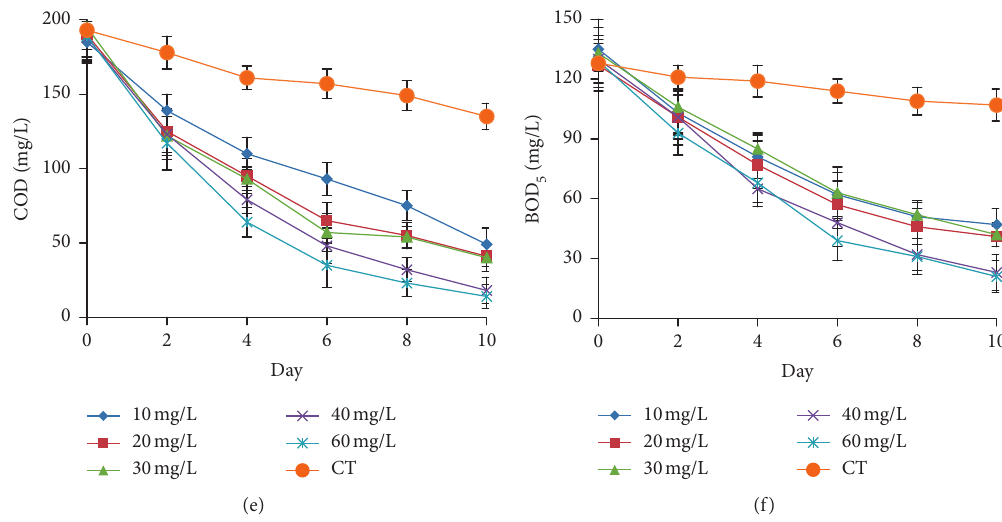
Figure 2: Changes of NH4 + (a), NO3 − (b), PO43 − (c), TP (d), COD (e), and BOD5 (f) concentrations in the treatment with different initial microalgae concentrations. Table 3: Flocculation activity and removal efficiency with different initial microalgae concentration. Initial microalgae concentration Flocculation activity